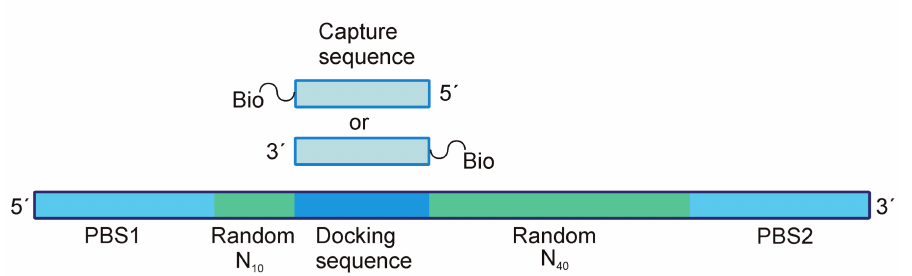
Figure 4. A general scheme of library design for a capture